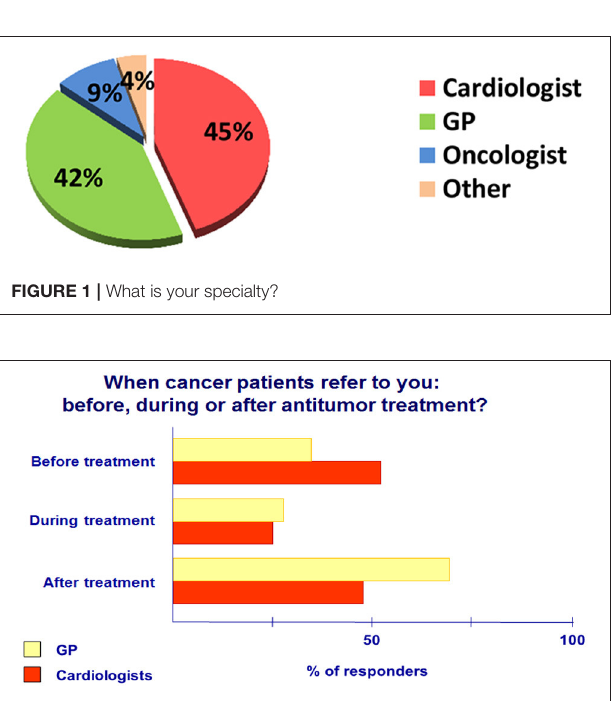
FIGURE 2 | When do cancer patients refer to you: before, during or after antitumor